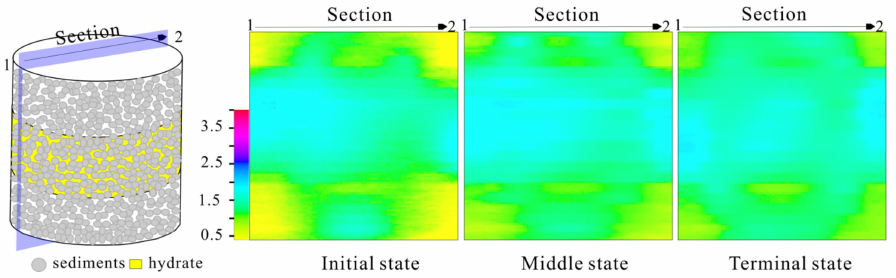
Figure 8. Resistivity change caused by the formation of hydrate in the vertical profiles of sediments. The hydrate formed in both fine-grained sediments and sandy